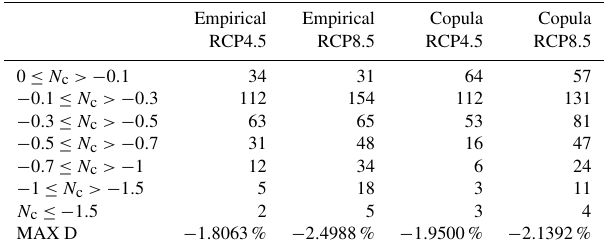
Table 8. Ensemble number of cells ( N c ) in each category of proba- bility difference (%) for RR20FD for empirical and copula method. MAX D denotes the maximum negative difference between future and past periods. N v concerns only cells with statistically signifi- cant difference. Empirical Empirical Copula Copula RCP4.5 RCP8.5 RCP4.5 RCP8.5